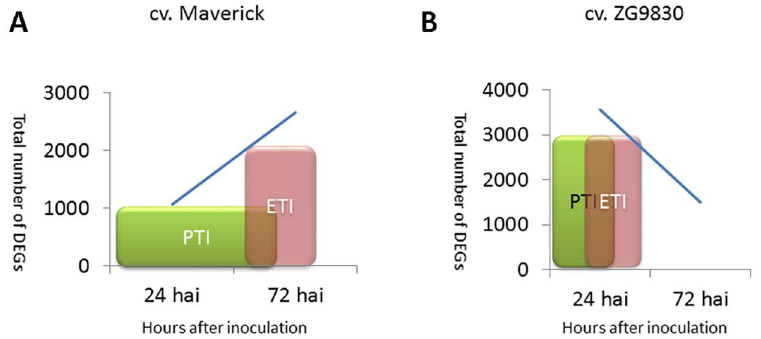
Fig 7. Hypothetical mechanisms of resistance to PssALF3. ( A ) Resistant plants of cv. Maverick. (B) Resistant plants of cv. ZG9830. PTI, pathogen-associated molecularpatterns (PAMP)-triggeredimmunity. ETI, effector-triggered immunity